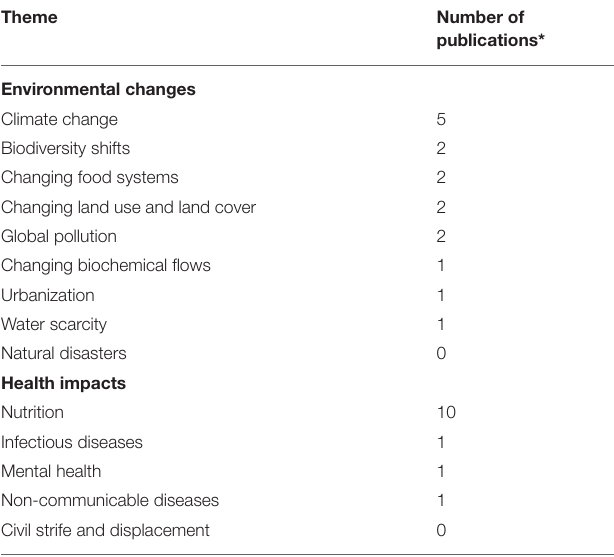
TABLE 2 | Number of original research publications by planetary health